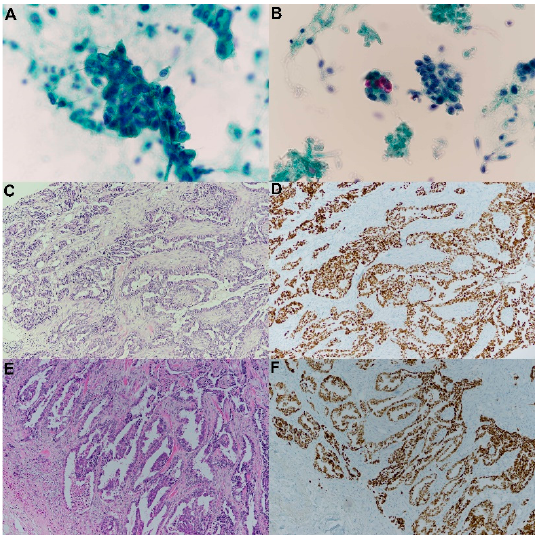
Figure A1. Pathology images of metastatic lesions. ( A ) Cytology of pancreatic metastasis, ( B ) cytology of thyroid metastasis, ( C ) hematoxylin and eosin (H&E) staining of breast metastasis, ( D ) thyroid transcription factor (TTF-1) staining of breast metastasis, ( E ) H&E staining of metastatic lesions in the subcutaneous layer of the right back, and ( F ) TTF-1 staining of metastatic lesions in subcutaneous layer of the right